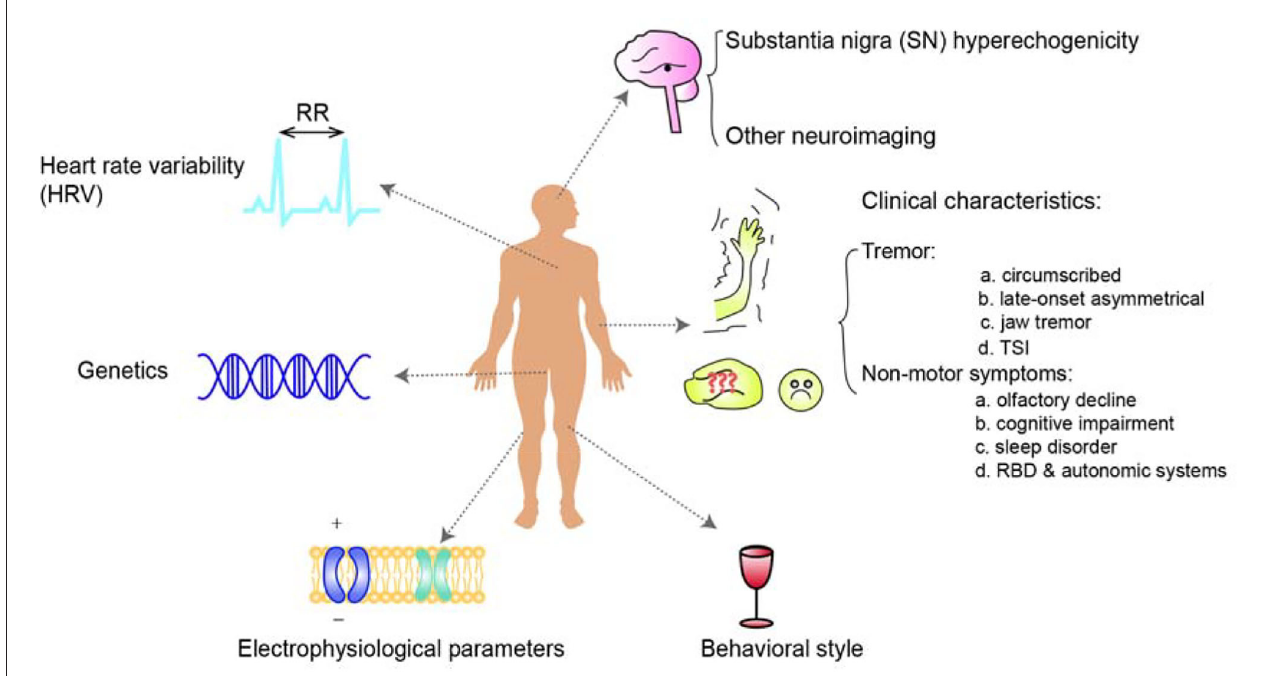
FIGURE 1 | An overview of the risk markers of Parkinson’s disease in patients with essential tremor. Essential tremor patients have an increased risk of the development of PD, especially those with SN hyperechogenicity in TCS. Similarly, ET patients with specific tremor or non-motor symptoms, additional HRV, genetic risk, or the other risk markers such as Tremor Stability Index are undergoing a higher risk of the development of PD